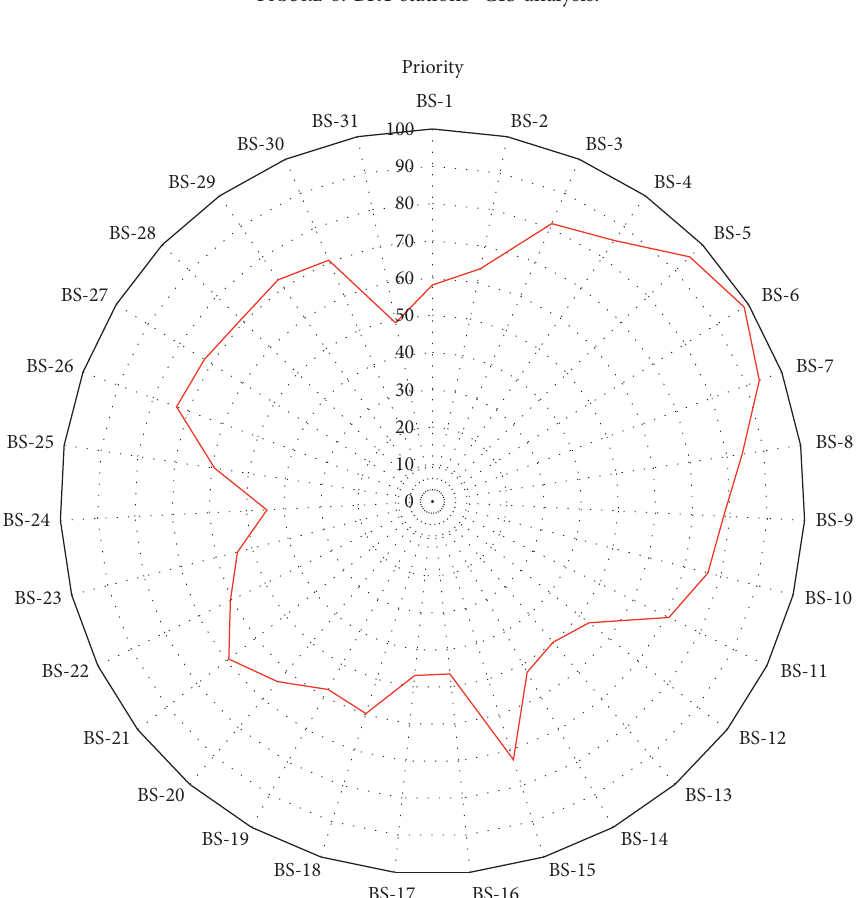
Figure 8: BRT stations’ GIS